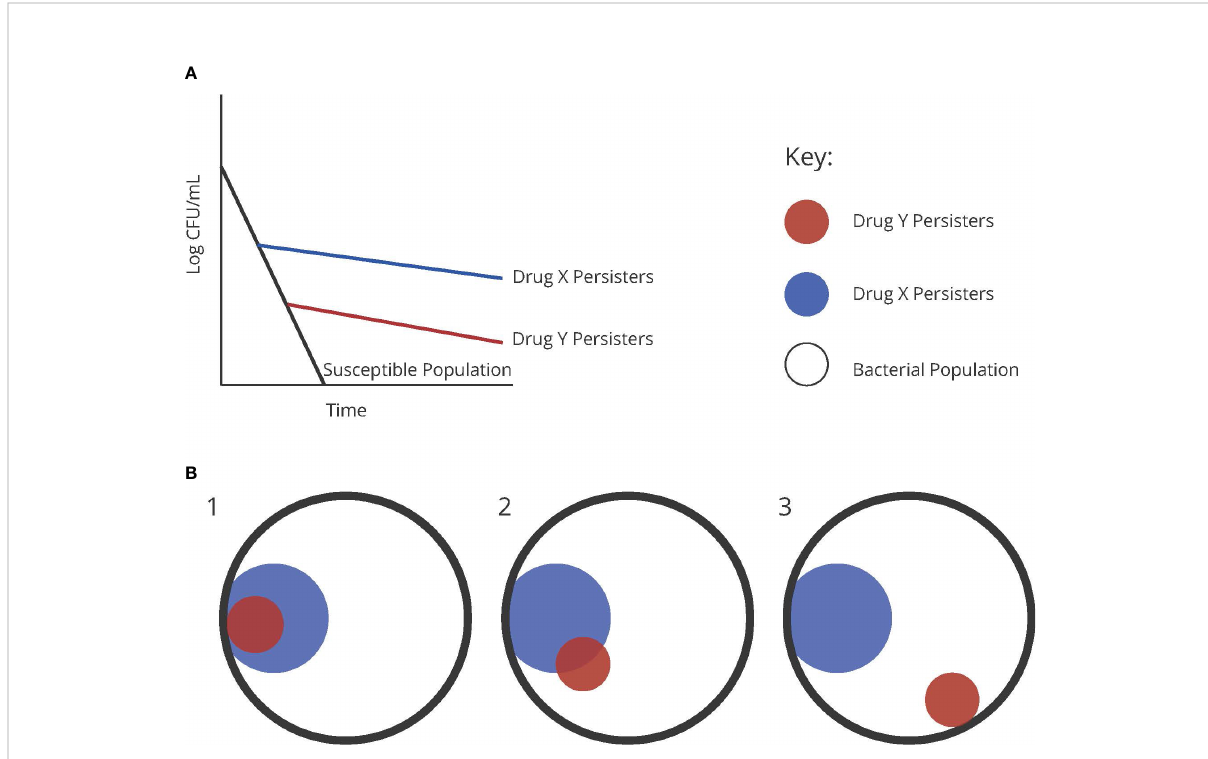
FIGURE 2 (A) Graphical representation of persister populations to two theoretical drugs, x and y, compared to a susceptible population of bacteria. (B) Diagrams representing the possible distributions of heterogenous persister populations of two different